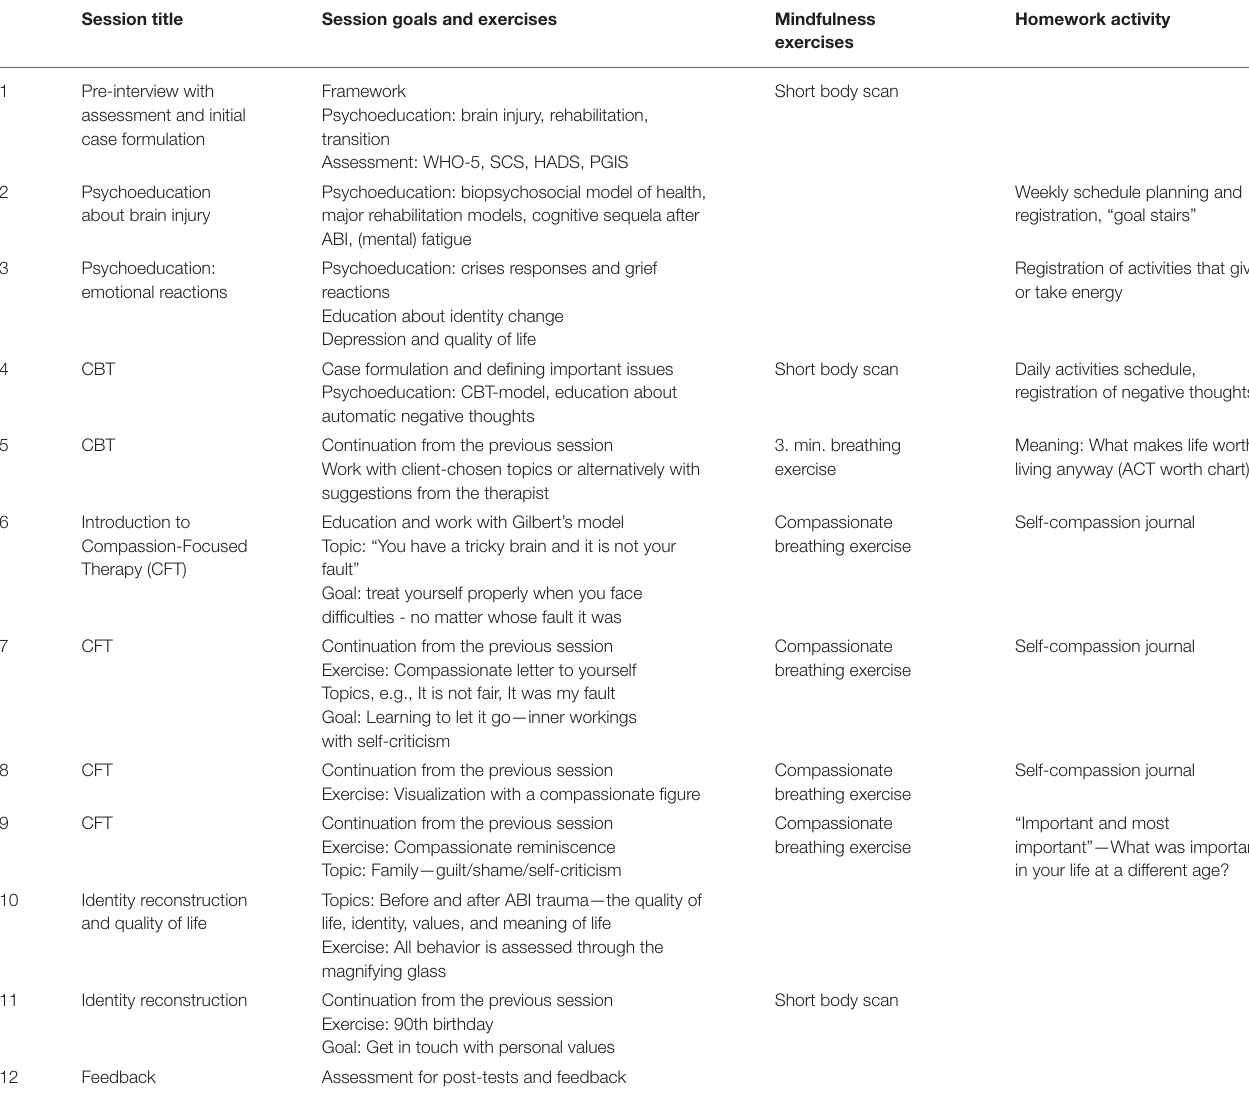
TABLE 2 | Overview of interventions in the BackUp program, by